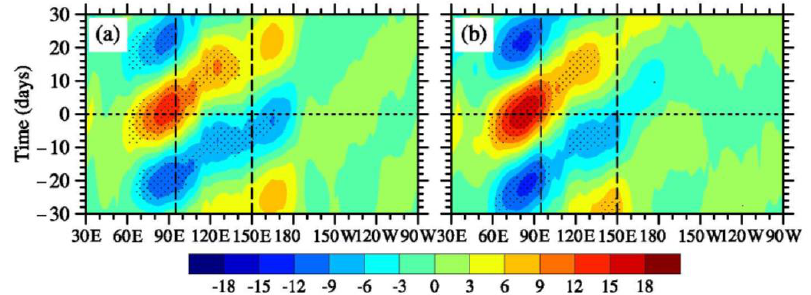
Figure 8. Longitude-time diagram of the MJO OLR (w·m −2 ) averaged over the 10° S–10° N lag regressed onto that averaged over the 10° S–10° N, 70°–90° E during the ( a ) positive and ( b ) negative phases of PIOAM. Results passing the significance test at the 90% confidence level are stippled.